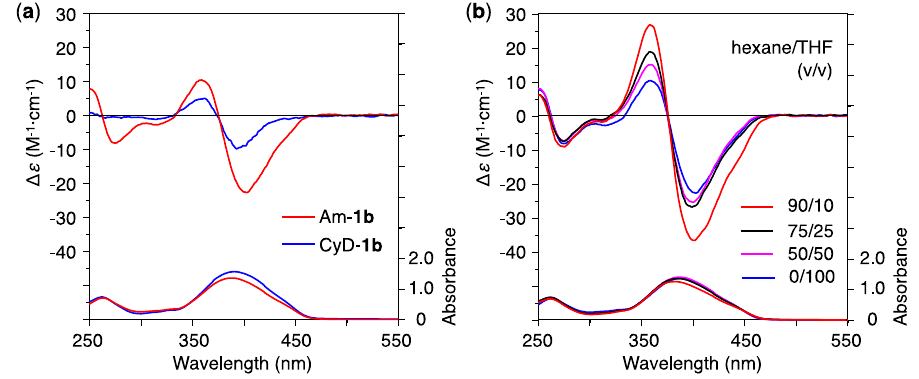
Figure 2. ( a ) CD and absorption spectra of Am- 1b and CyD- 1b in THF at 25 °C; ( b ) CD and absorption spectra of Am- 1b in hexane/THF (hexane: 0–90 vol %) at 25 °C. (Glucose unit) = 1.0 × 10 − 5 M. spectra of Am- 1b in hexane/THF (hexane: 0–90 vol %) at 25 ◦ C. [Glucose unit] = 1.0 × 10 − 5